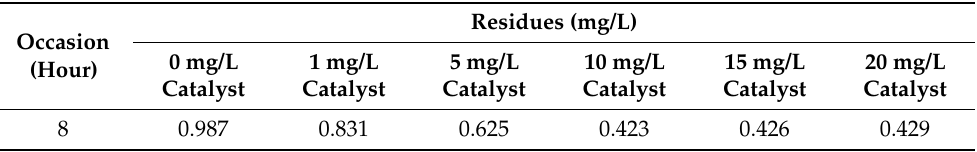
Table 2. Effect of catalyst concentration on decontamination of Spiromesifen in media under direct